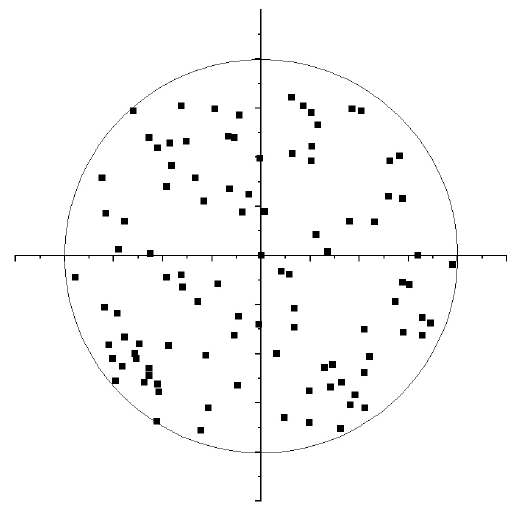
Figure 2. Example of the sensor distribution for N = 100 and 200 m radius